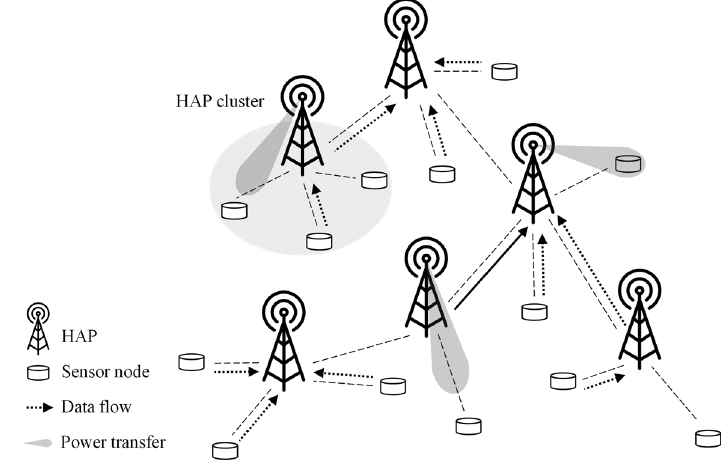
Figure 1. System architecture of MCSS.